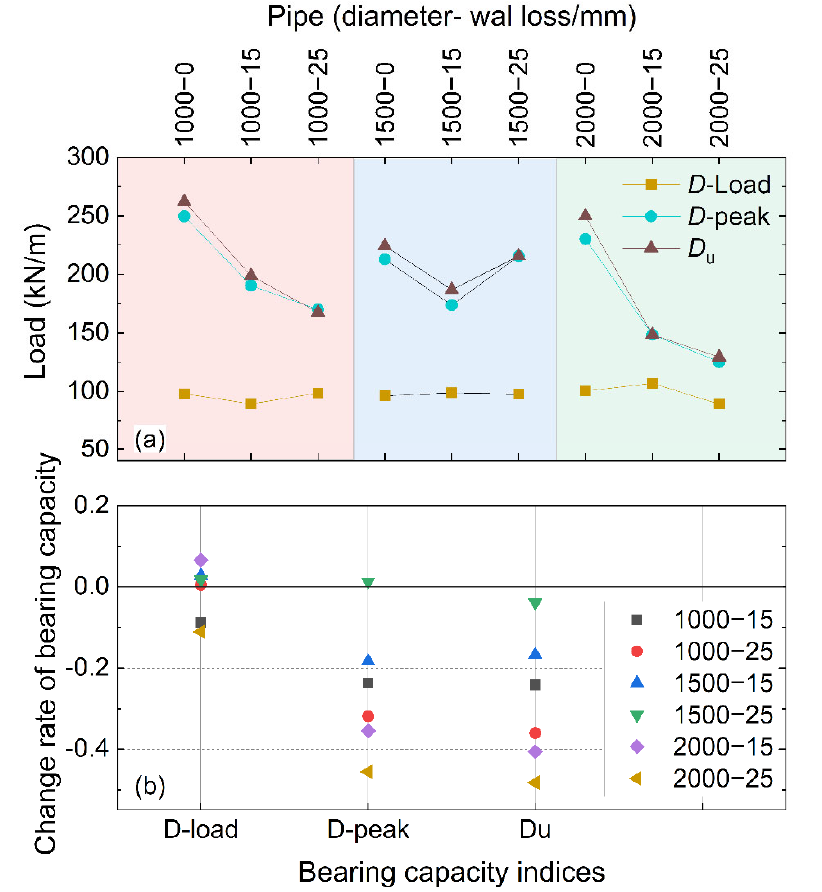
Figure 13. Load ‐ bearing capacity of concrete pipes with different diameters and wall losses, where ( a ) shows the D ‐ load, peak load, and ultimate load of each testing pipe, ( b ) shows the rate of change in load carrying capacity for each diameter of pipe after a wall loss of 15 and 25 mm in the crown.